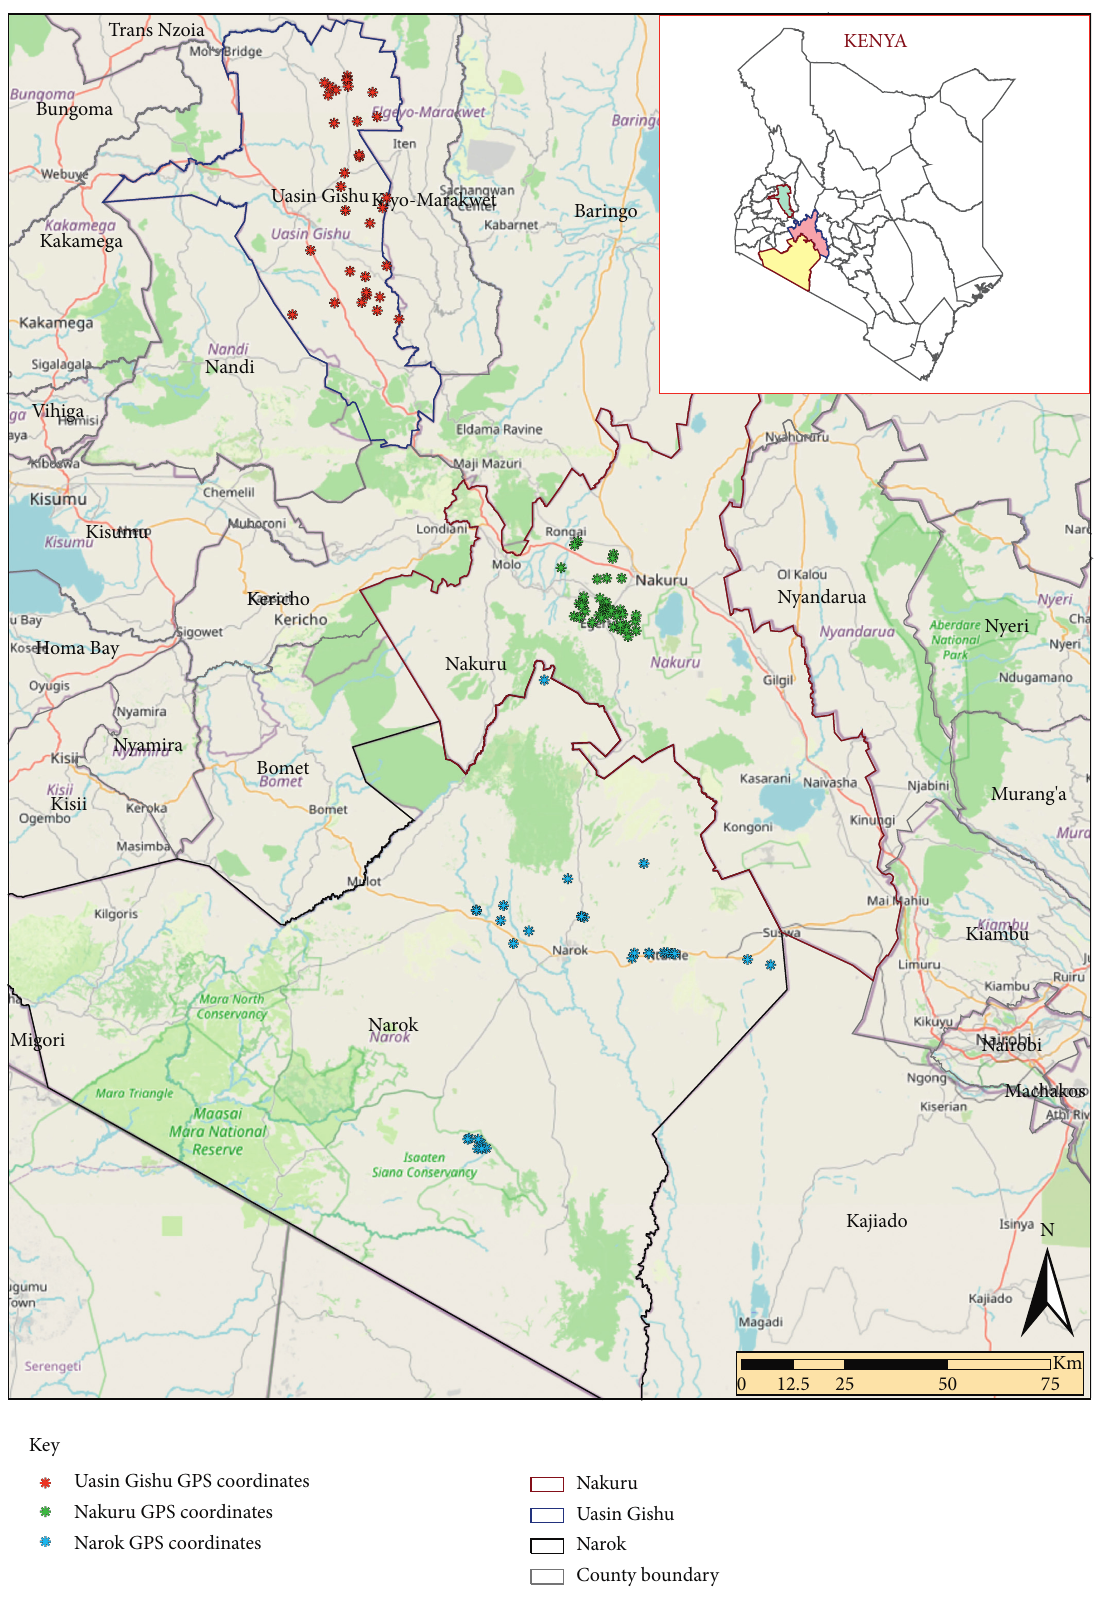
Figure 1: The location of each sampling site generated using the geographical positioning system